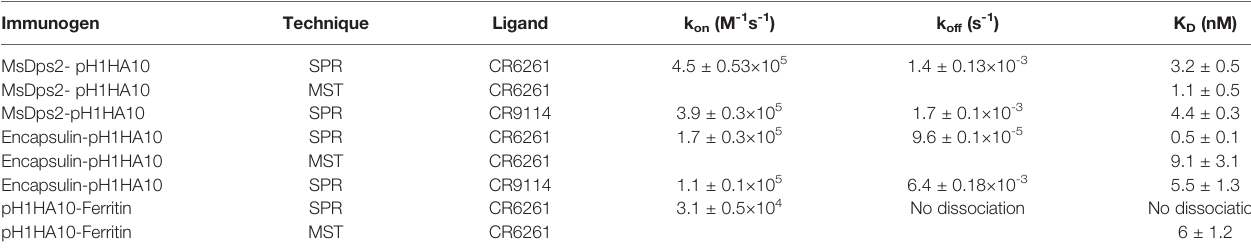
TABLE 2 | Binding parameters for interaction of nanoparticles with bNAb CR6261 measured by SPR and MST.